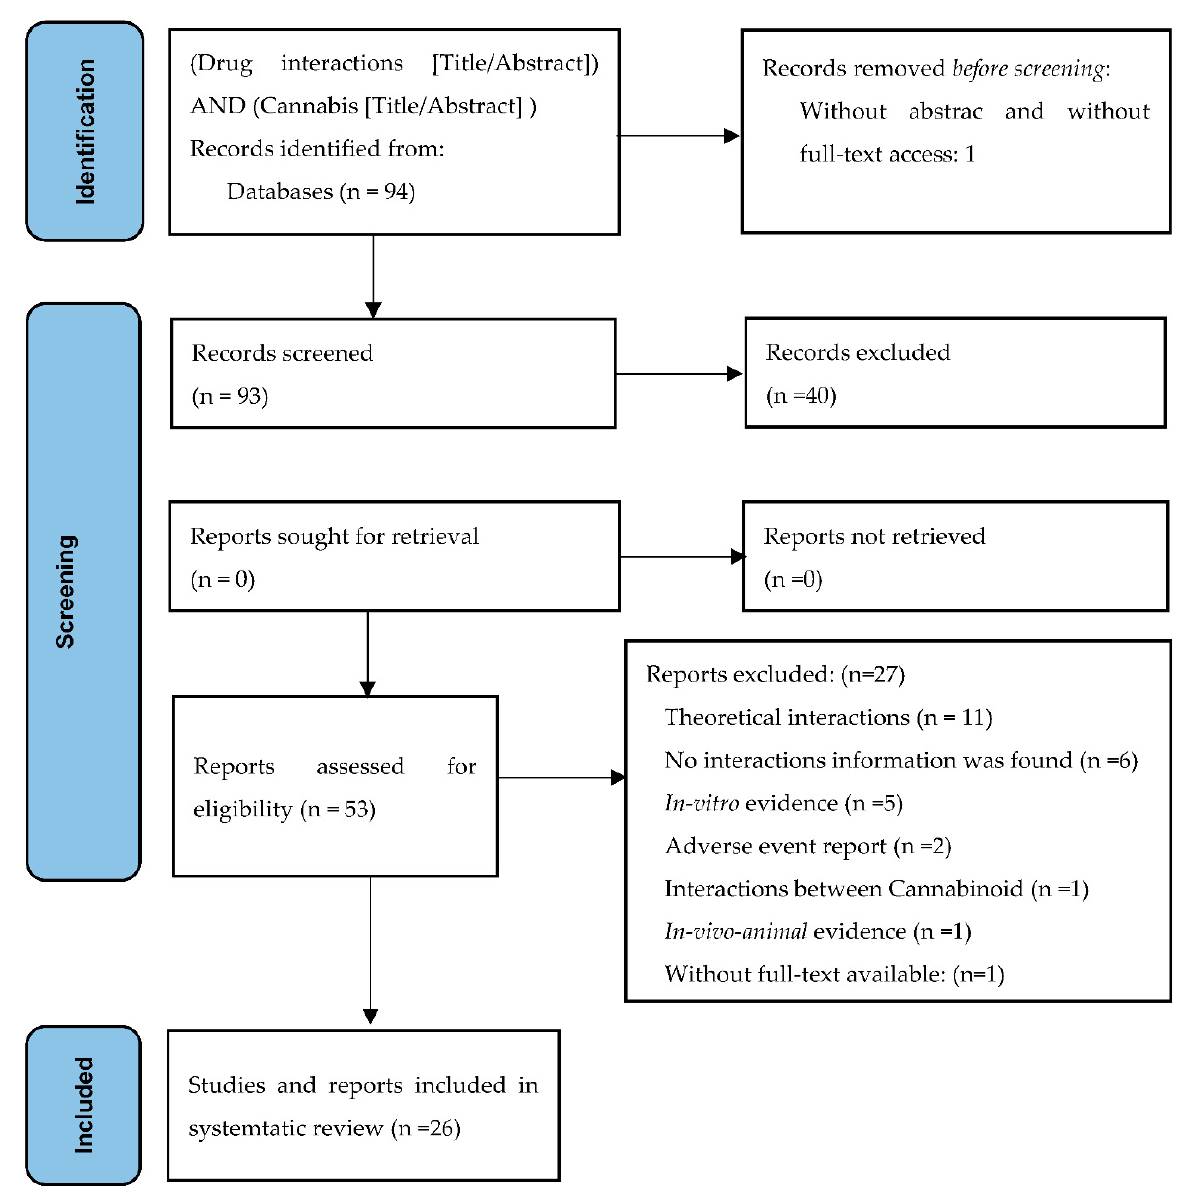
Figure 1. Preferred reporting items for systematic review and meta-analysis (PRISMA): flow diagram for the systematic review of cannabis–drug interactions.